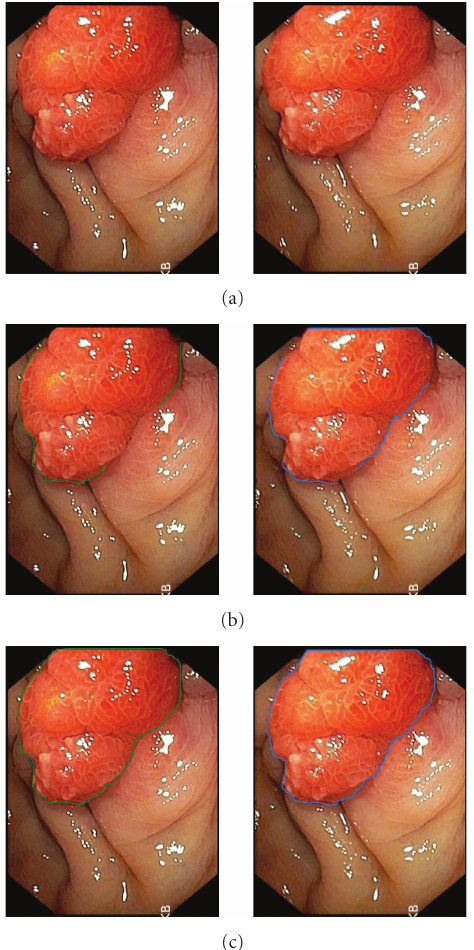
Figure 1: String matching process and boundary formation on two successive images of a sequence: (a) original acquired images from endoscope, (b) initial contour extraction, (c) boundary formation: the discontinuities have been